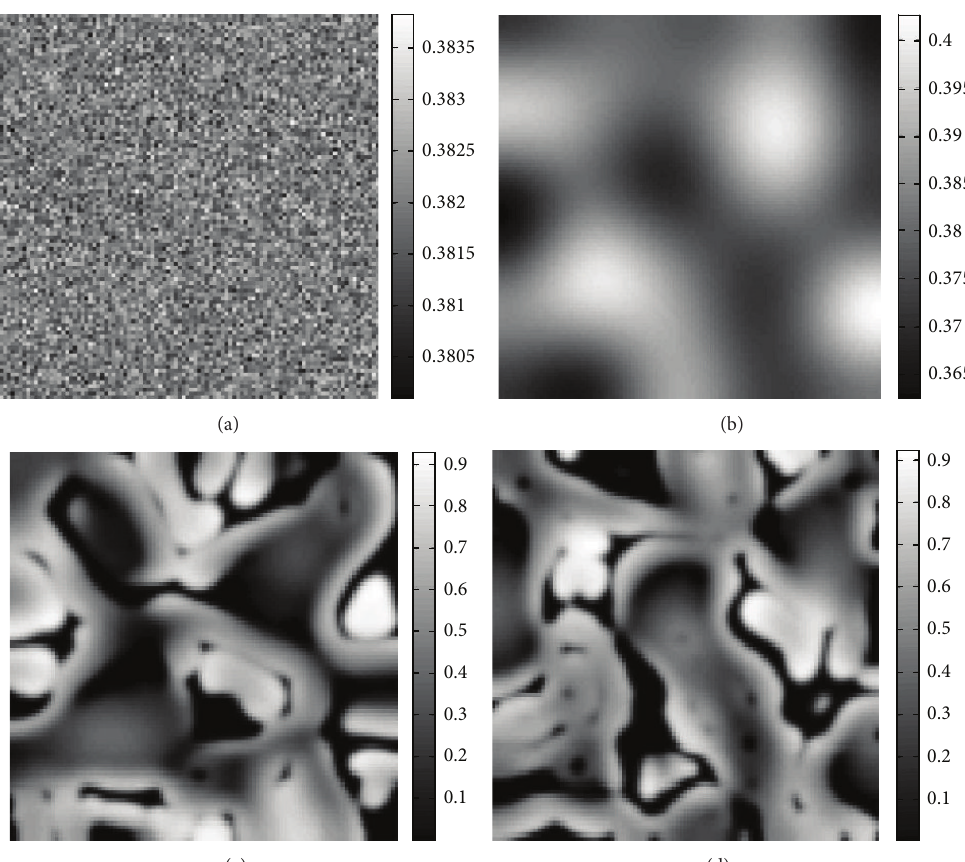
Figure 5: Chaotic wave pattern of the prey 𝑢 obtained with model (3) with 𝑐 1 = 5.15 and 𝑞 1 = 1.07 . Iterations: (a) 0 , (b) 50000 , (c) 100000 , and (d) 200000